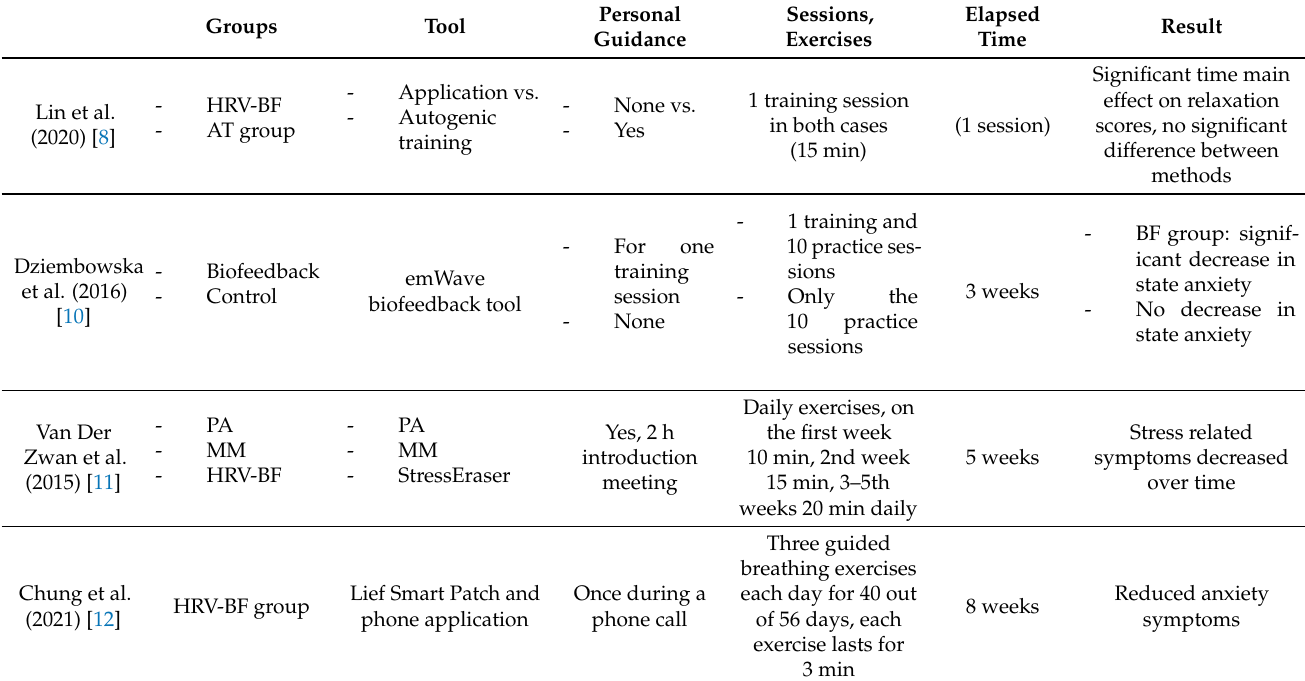
Table 1. Comparison of major relaxation